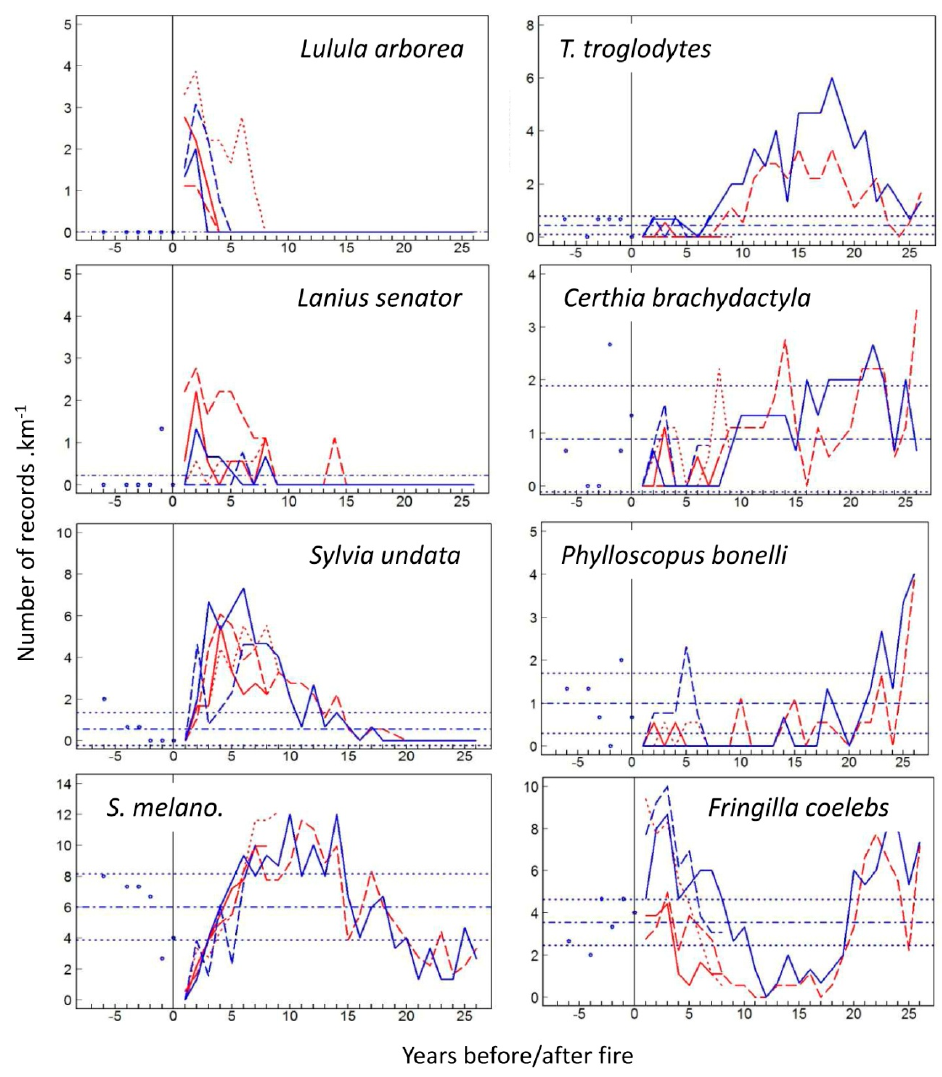
Figure 2. Postfire response curves of eight common bird species; x -axis: years since the last fire; y -axis: number of individuals · km − 1 . In red: transect C; in blue: transect L. Solid line: number of records after the first fire; dashed line: after the second fire; dotted line: after the third fire. Circles (and dash-dotted line): prefire control (and mean ± 1 s.d.).